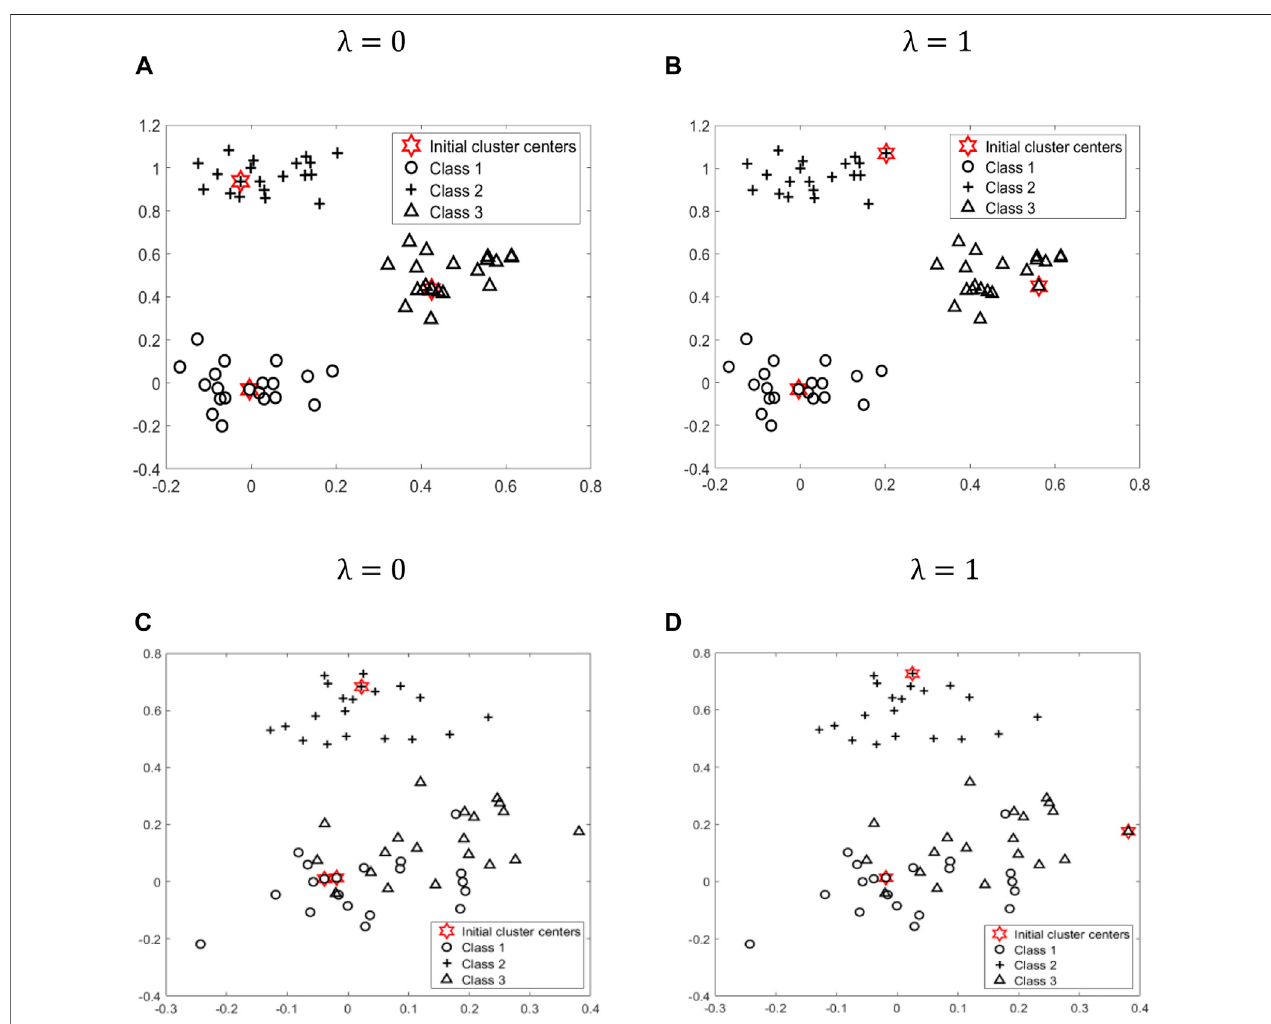
FIGURE3| Tofurtherillustratetheimpact ofparameter λ ,wegeneratetwotypesofdatasets, (A) , (B) and (C) , (D) ,withdifferentdistribution fromamixtureofthree bivariate Gaussian densities. Class 1, Class 2, Class 3, and initial cluster centers are represented by different shapes: circle, cross, triangle, and star, respectively.